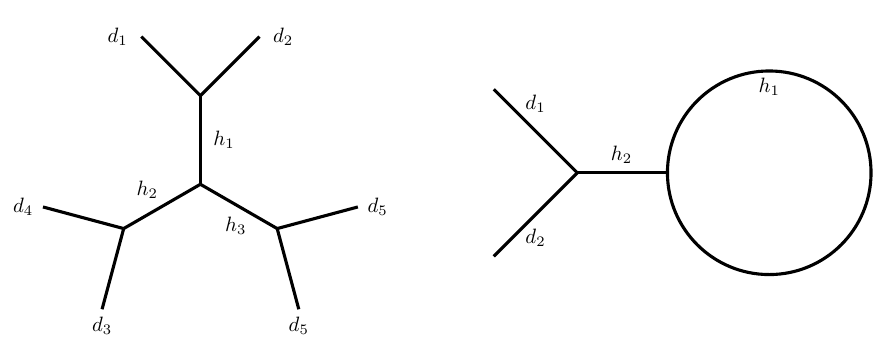
Figure 1. The sphere six-point block in the trifundamental channel (left) and the torus two-point block in the OPE channel (right). Our c -recursion representation for arbitrary sphere and torus N -point blocks enables recursive evaluation of these blocks; we work these cases out explicitly in section 4.4.